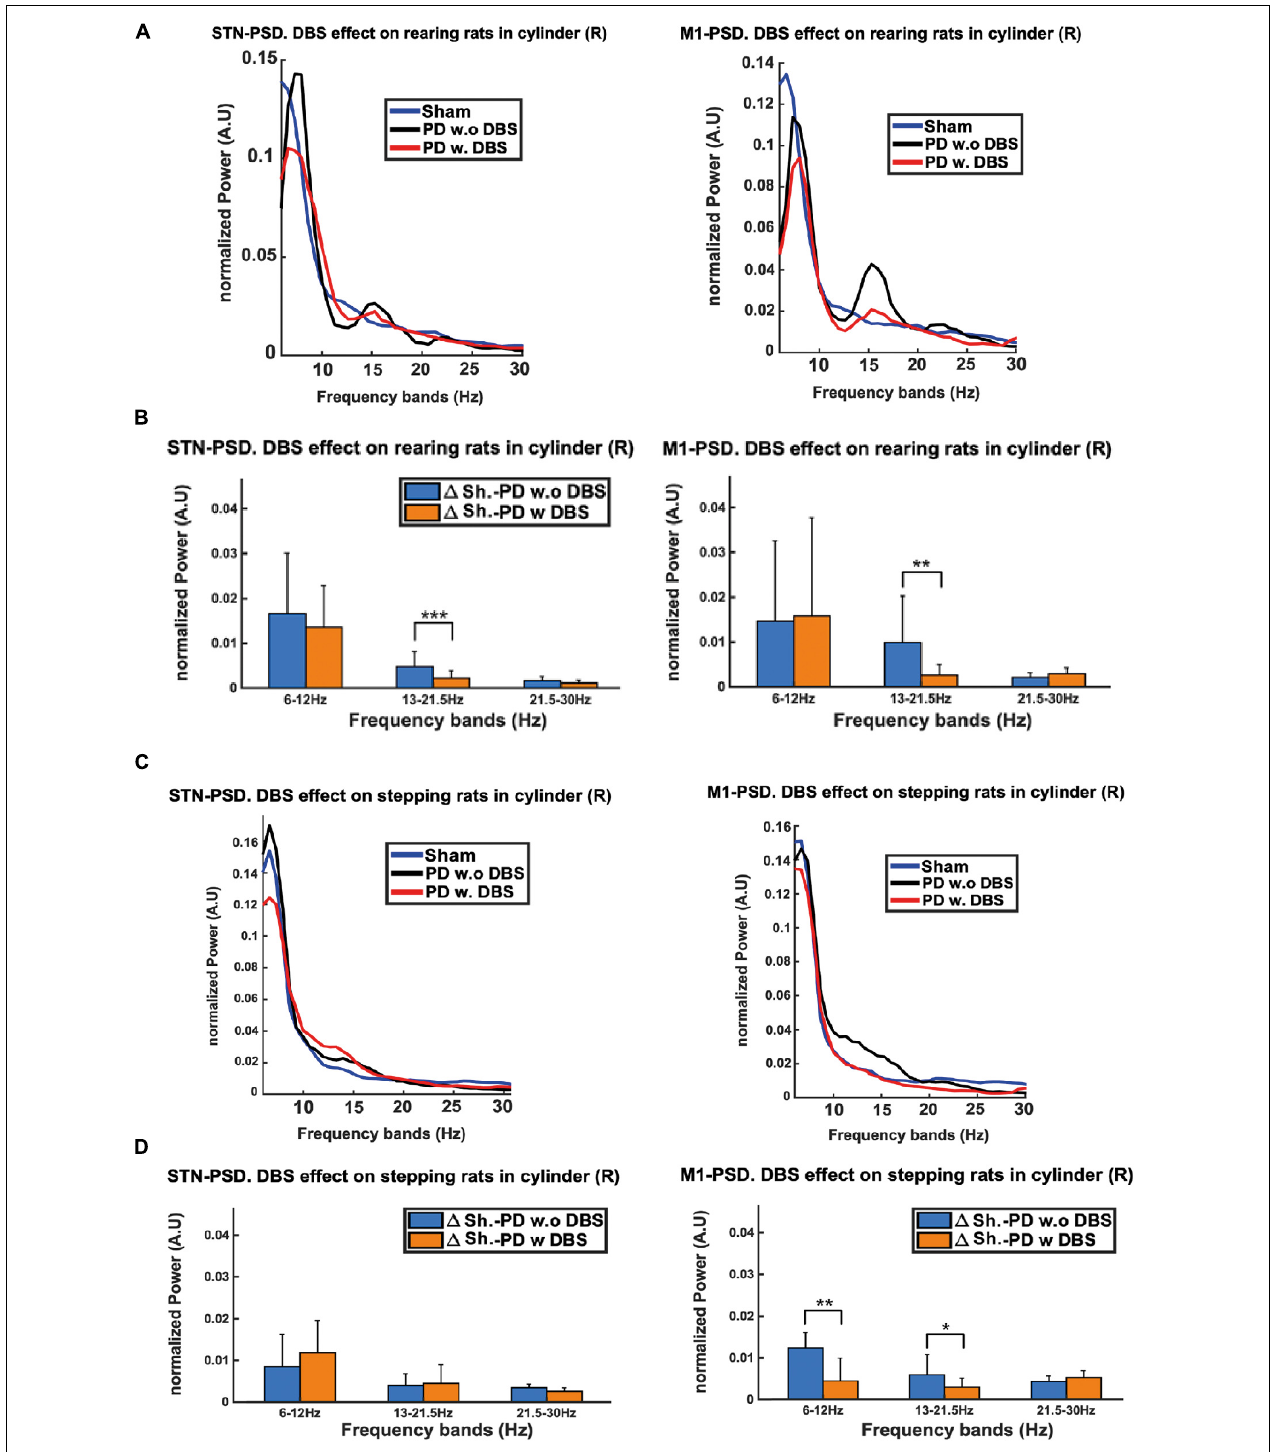
FIGURE 10 | The excessive beta power of PD rats during stepping and rearing was compared between STN and M1 regions. (A) Although excessive beta can be seen in both regions, the M1 exhibits a more pronounced excess during rearing as compared to the STN. (C) The beta power excess during stepping only becomes apparent for M1 and not for the STN. We also observe that the administration of DBS lowers the beta excess power in both rearing and stepping episodes. (B,D) Euclidean Distance (ED) was used to quantify the differences between the PSDs of PD DBS-ON vs. sham and PD DBS-OFF vs. sham rats. The low beta band shows significant decreases in the ED’s upon stimulation, which can be observed in both the STN and M1 during rearing, but only in M1 during stepping. Level of significance: (* p < 0.05, ** p < 0.01, and *** p < 0.001). Figure adapted from Mottaghi (2020).